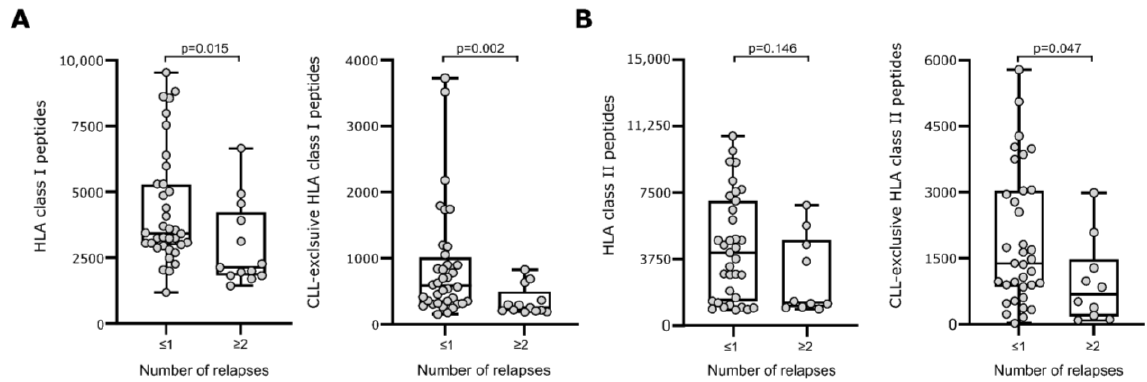
Figure 2. HLA presentation of antigenic peptides according to disease’s course in terms of observed relapses. Numbers of total (left panel) and CLL-exclusive (right panel) HLA class I- ( A ) and HLA class II-restricted ( B ) peptides according to the number of observed relapses. Dots represent data from individual patients. Boxes represent median and 25th to 75th percentiles. Brackets indicate p -values (Mann – Whitney U-test). Abbreviation: p , p -value.